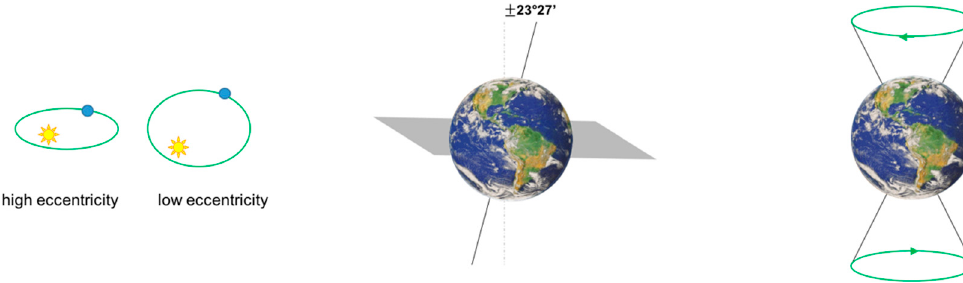
Figure 2. Three Milankovitch cycles.